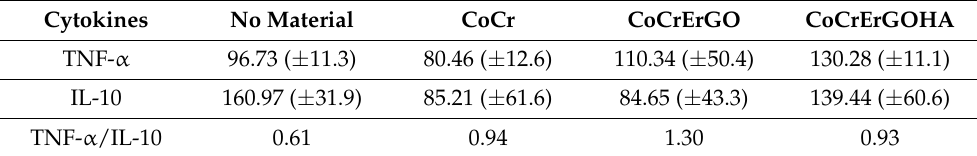
Table 2. Concentration of TNF- α (pg/mL) and IL-10 (pg/mL) in the supernatants of macrophages cell cultured for 72 h in the presence of different modified surfaces. In ( ), there are the ± SD values. The data are the mean results of three different independent assays; each one of which has an independent triplicate for each